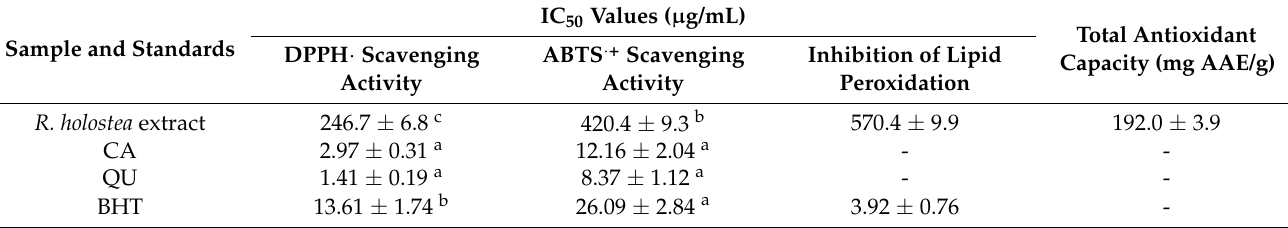
Table 3. Antioxidant activity of R. holostea aerial part extract.